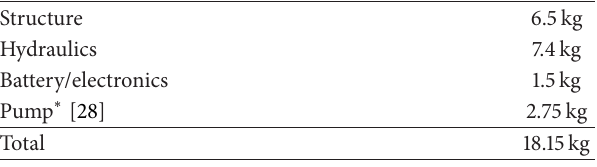
Table 1: Weight of HNP + PAS ∗